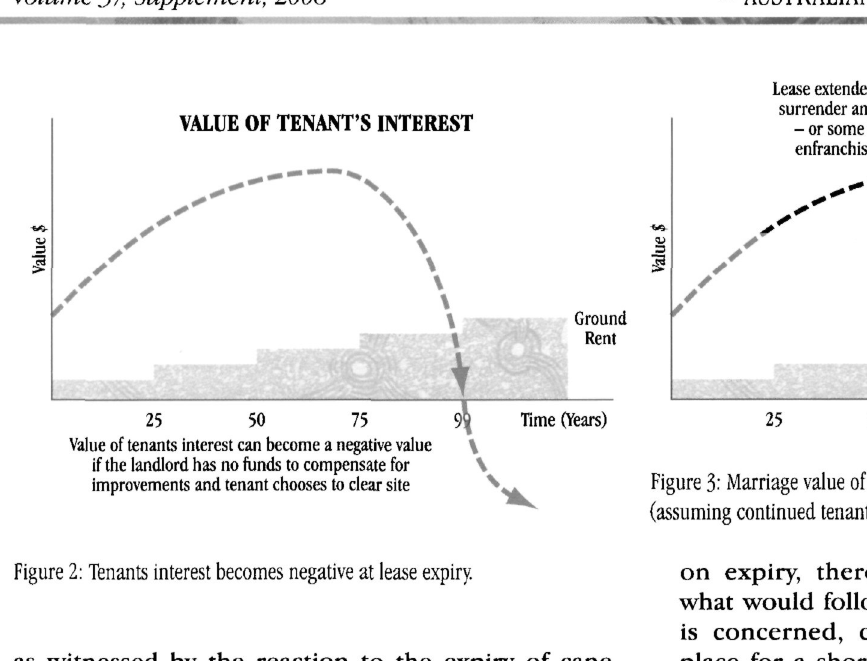
Figure 2: Tenants interest becomes negative at lease expiry.